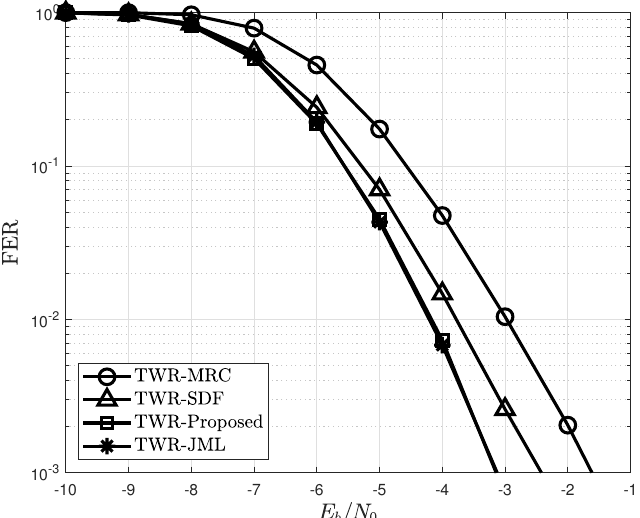
Figure 8. FER of the proposed detection for different detection schemes in a two-way